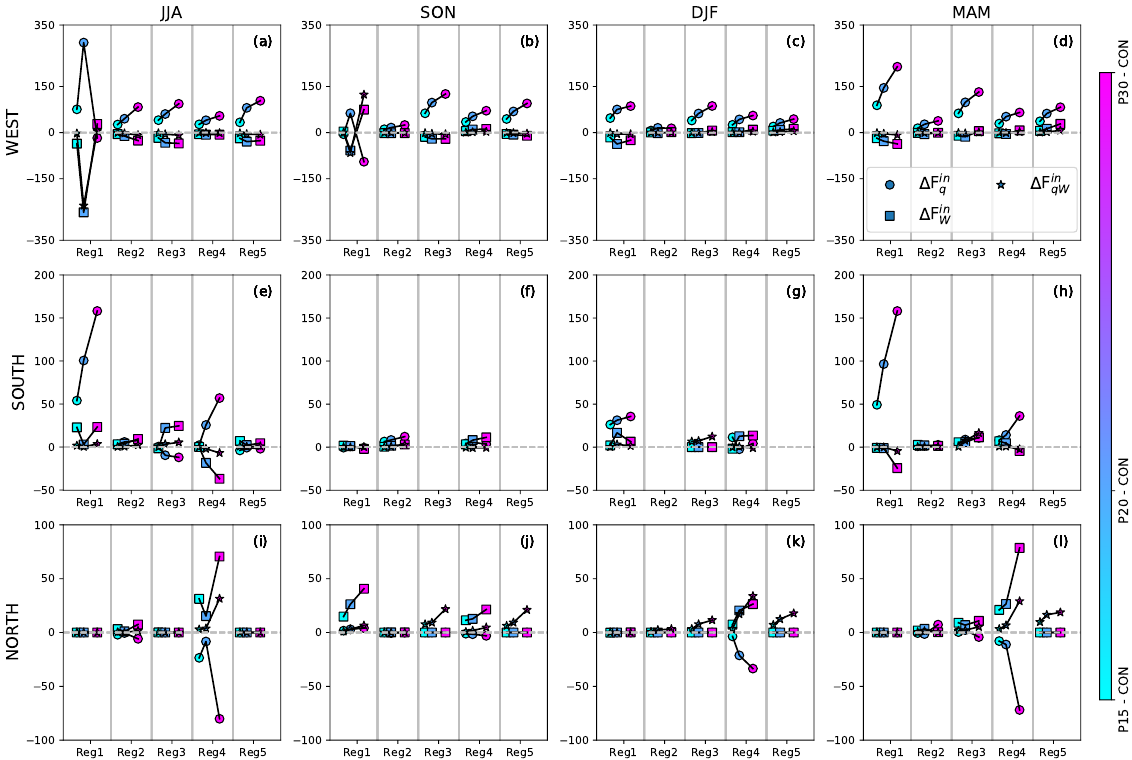
Figure 12. Decomposition of seasonal-mean differences in vertically integrated moisture influx (kg m − 1 s − 1 ) across a boundary of each region into components due to changes in moisture (circle), advection (square) and the product term (star) with P15 minus CON in cyan, P20 minus CON in blue and P30 minus CON in magenta for each season ( a ) JJA, ( b ) SON, ( c ) DJF, and ( d ) MAM. ( a – d ) are for changes across the western boundary, ( e – h ) are for changes across the southern boundary and ( i – l ) are for changes across the northern boundary. The eastern boundary of all regions has low vertically integrated horizontal moisture flux and thus is not